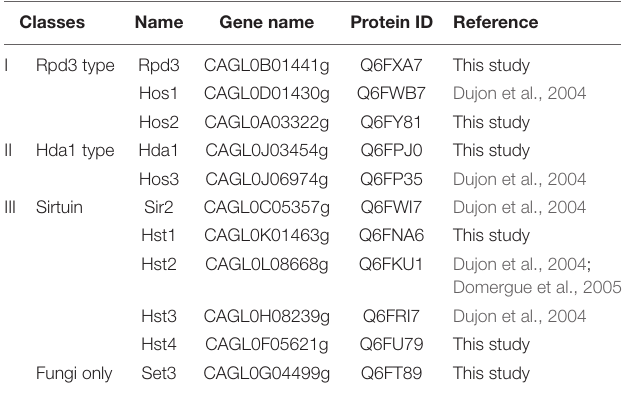
TABLE 2 | Gene and protein accession numbers for HDACs expressed in C. glabrata